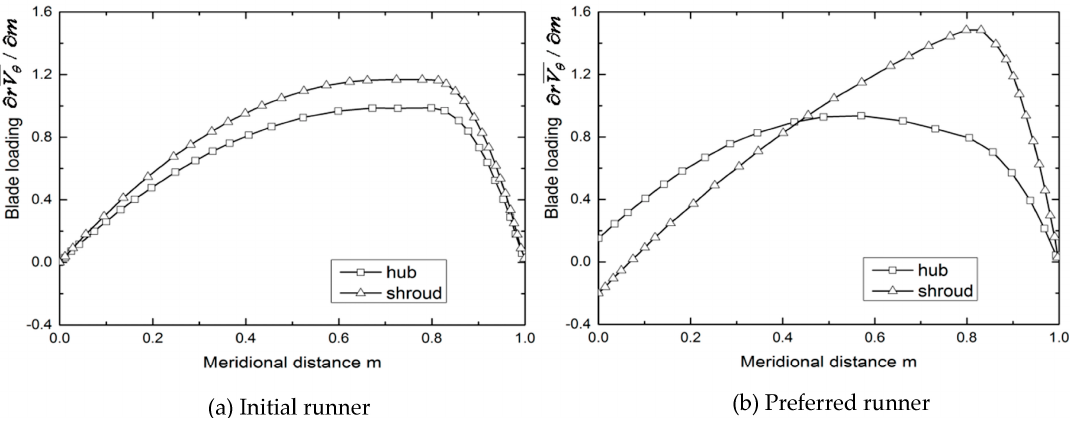
Figure 7. Blade loading distributions of the initial runner and the preferred runner.